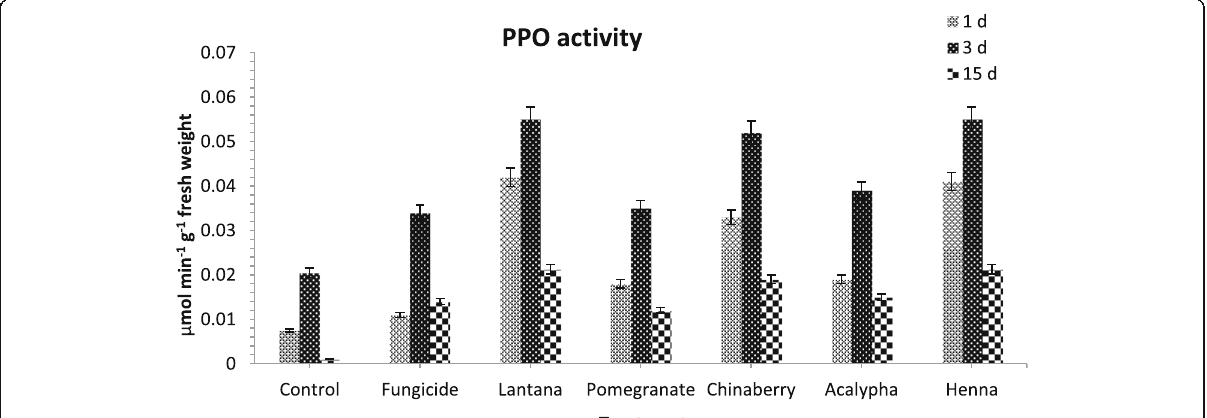
Fig. 4 Effect of some plant extracts on the activity of polyphenoloxidase (PPO) enzyme in wheat leaves cv. “ Gemmeiza-7 ” infected with Puccinia triticina , as compared to the fungicide Fungshow